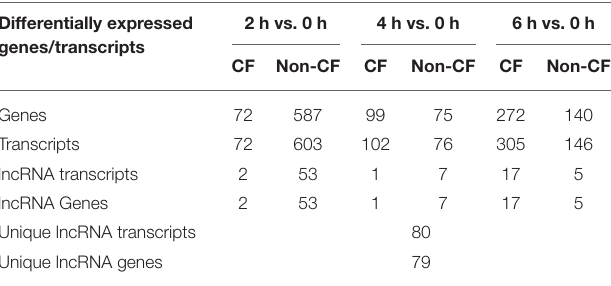
TABLE 3 | Genes and lncRNAs differentially expressed in CF and non-CF cells at different time points of infection compared to the non-infected status (0